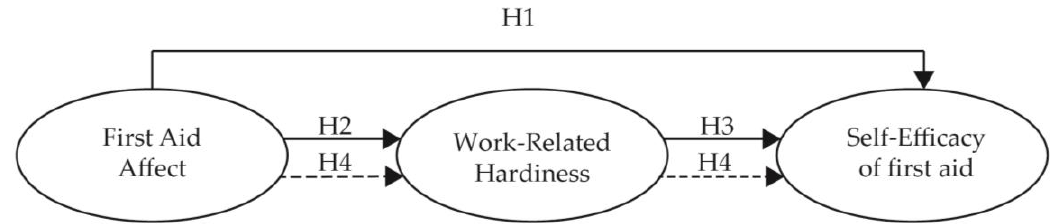
Figure 1. The theoretical model.